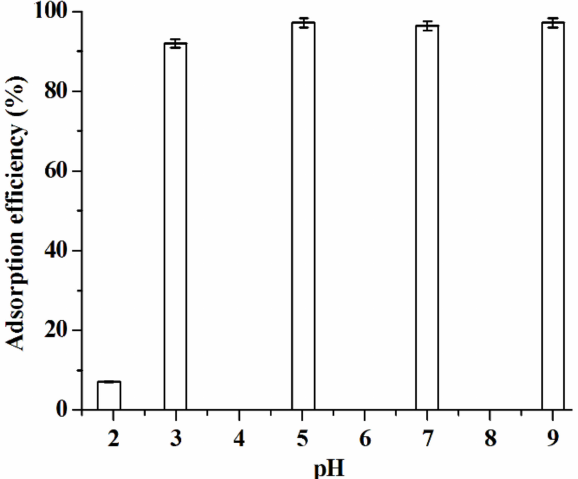
Figure 9. Effect of pH of water phase on the adsorption efficiency of [C 3 mim] + Cl − @SiO 2 . Experi- mental conditions: C baicalin = 5.0 × 10 − 5 mol · L − 1 ; [C 3 mim] + Cl − @SiO 2 , 40 mg; volume of baicalin aqueous solutable 10 mL; adsorption time, 10 min; adsorption temperature, 25 ◦ C. Experiments were conducted in triplicate.